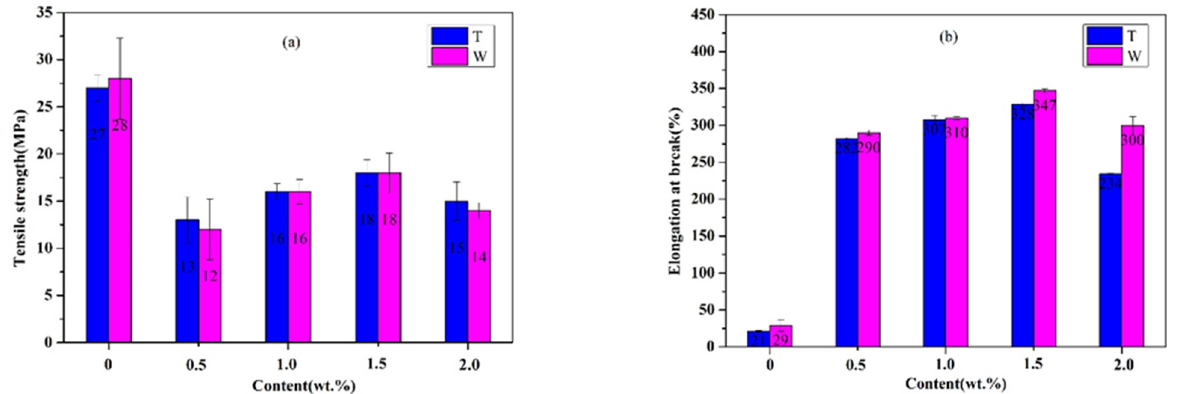
Figure 7 . Tensile properties of rubber-based composites with 1 wt.% CGF and different contents of Gr. ( a ) tensile strength, ( b ) elongation at break.